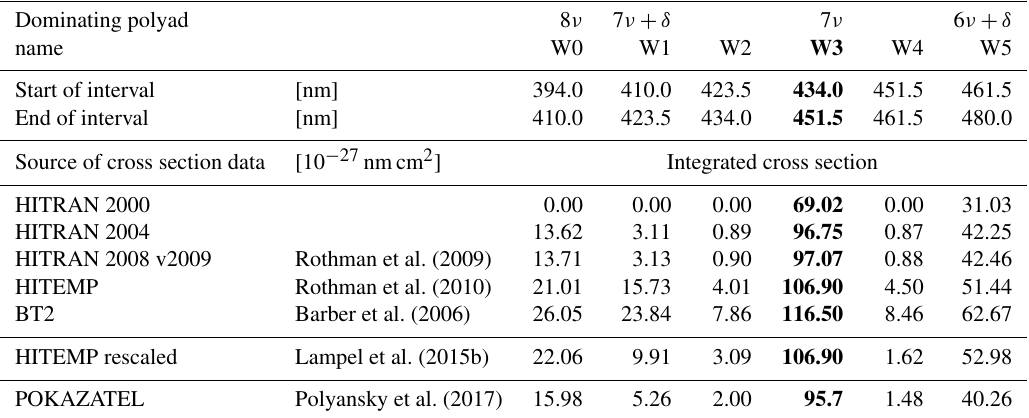
Table 6. Integrated absorption in [10 − 27 nmcm 2 ] over each of the wavelength intervals W0–W5 for different sources of cross section data. Not only for the largest absorption structure W3 variations between the different compilations are seen, but especially integrated absorption values relative to W3 vary. The upper part of this table is adapted from Lampel et al. (2015b). The bold column marks the wavelength range, which was used as reference in Table 7 following the scheme from Lampel et al. (2015). These data are visualised in Fig. 11.